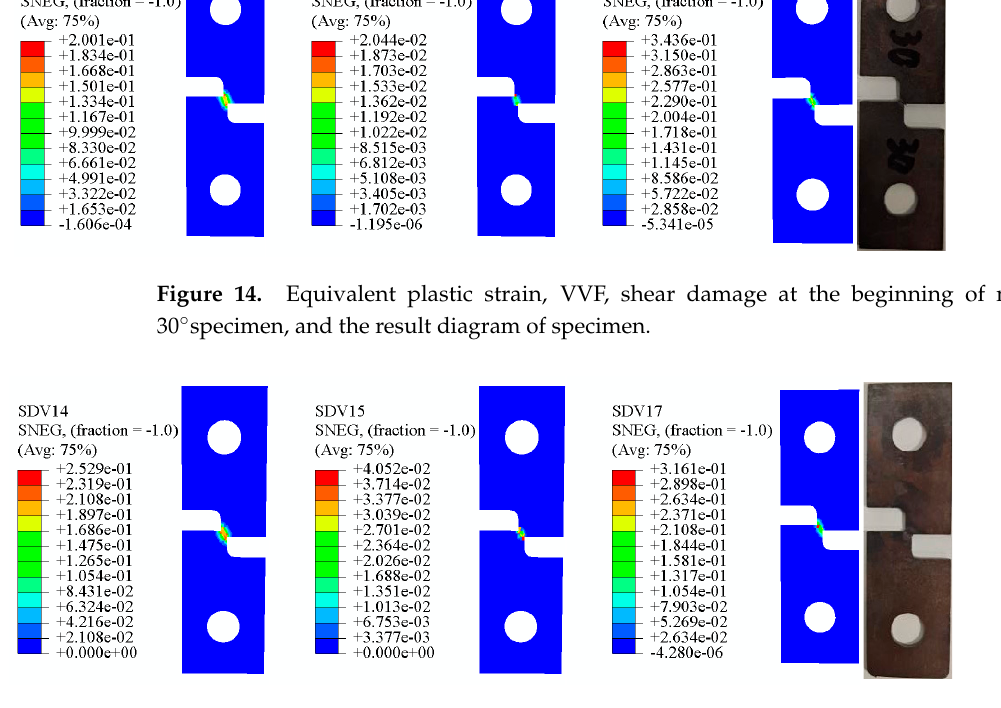
Figure 15. Equivalent plastic strain, VVF, shear damage at the beginning of microcrack in 45° spec- imen, and the result diagram of the specimen.